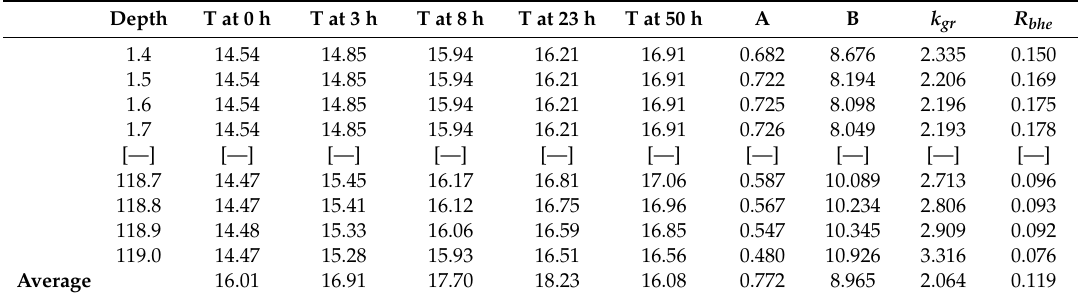
Table 1. A selection of the dataset containing all the measured temperatures in time and space. Column A and B are the Infinite Line Source (ILS) model estimations for the slope and intercept, respectively (Equation 5), as obtained by log-linear regression for each row. Columns k gr and R bhe are the estimates for the ground and BHE properties as solutions of Equation (7) applied to each row.